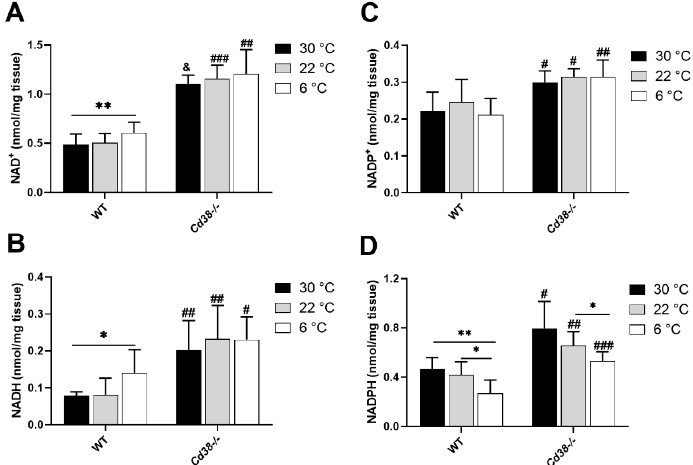
Figure 1. Cold exposure increases NAD(H) levels and decreases NADPH levels in liver from WT mice. Livers were harvested from WT and Cd38 − / − mice housed at 30 °C for 7 days (30 °C, black bars), or at 22 °C for 7 days (22 °C, grey bars), or at 22 °C for 6 days and at 6 °C for 1 day (6 °C, white bars). For dinucleotide content assay, tissues were minced on ice and then deproteinized in PCA or NaOH. Acid-extracted samples were used to evaluate NAD + and NADP + ( A , C ), whereas base-extracted samples were used to determine NADH and NADPH levels ( B , D ). Results are the means ± SD ( n = 6–7). Data analyzed by ANOVA with Tukey’s test: *, p < 0.05; **, p < 0.01; data analyzed by Student’s t test: # , p < 0.05; ## , p < 0.01; ### , p < 0.001; & , p < 0.00001 compared with the corresponding